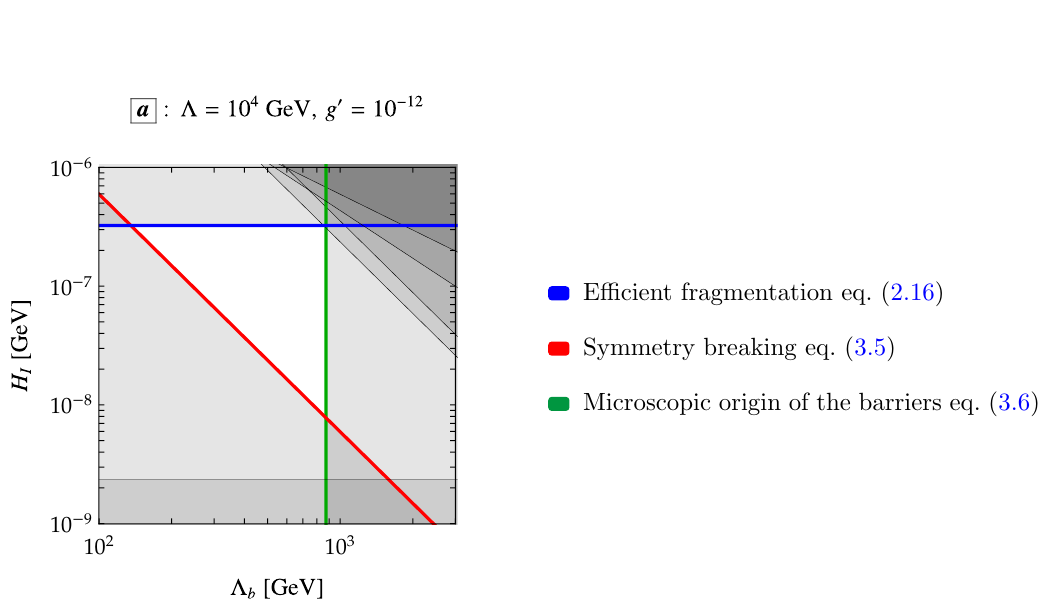
Figure 18 . Details of the origin of the constraints delimitating the blue regions presented in sec- tion 3.1 and (cid:12)gure 4, for benchmark points a , corresponding to the case where relaxation happens through Higgs-dependent barriers, during a stage of in(cid:13)ation, where the relaxion is a subdomi- nant component of the energy density of the universe and where the relaxion stops because of fragmentation .